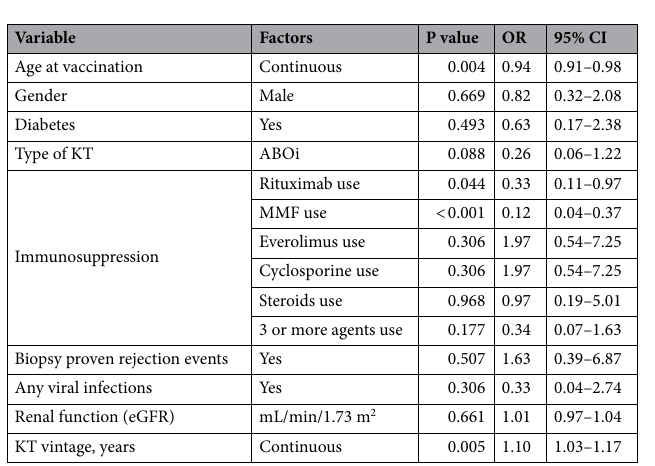
Figure 1. Rate of anti-SARS-CoV-2 S IgG seropositivity after the second dose of the BNT162b2 mRNA vaccine. ( A ) Comparison of seropositivity rates after the second vaccine dose between the control (Ctrl) and kidney transplant (KT) recipients. Seropositivity were defined as anti-SARS-CoV-2 S IgG antibody titers of ≥ 0.80 or ≥ 15 U/mL. ( B ) Comparison of seropositivity rates after the second mRNA vaccine dose between the ABO blood-type compatible (ABOc) and ABO blood-type incompatible (ABOi) KT recipients. ( C ) Trends in anti-SARS-CoV-2 S IgG antibody titers. *Second mRNA vaccination; **cutoff for the presence of neutralizing antibody (≥ 15 U/mL).